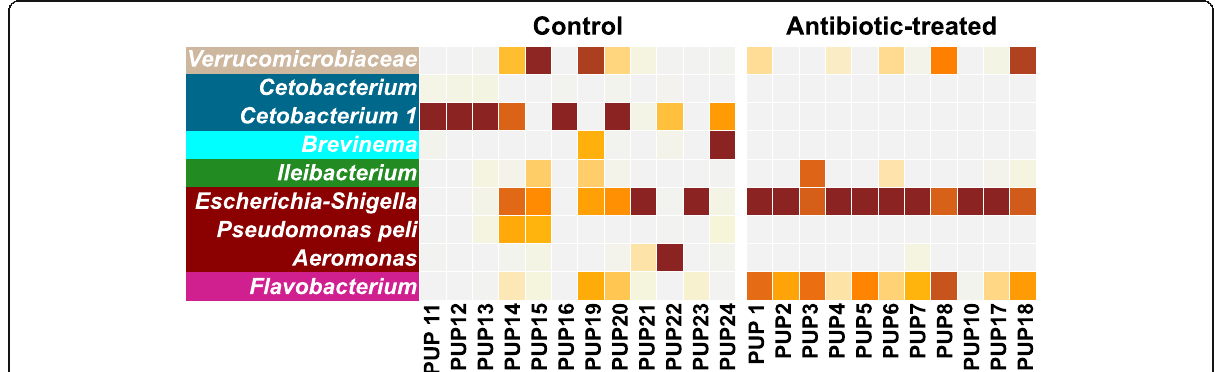
Fig. 3 Heatmap displaying top ASVs responsible for dissimilarity between control and antibiotic-treated fish. Heatmap of the relative abundance of 09 ASVs (genus- or family-level assignments are indicated) identified using SIMPER analysis. These taxa contributed cumulatively to 50% of community dissimilarities. Each square represents the relative abundance of the given ASV, higher intensity of the brown color correlates with high relative abundance. Taxa are color-coded as per the phylum-level assignments as: Verrucomicrobia : orange; Fusobacteria : yellow; Spirochetes : pink; Firmicutes : sky-blue; Proteobacteria : green, and Bacteroidetes : grey